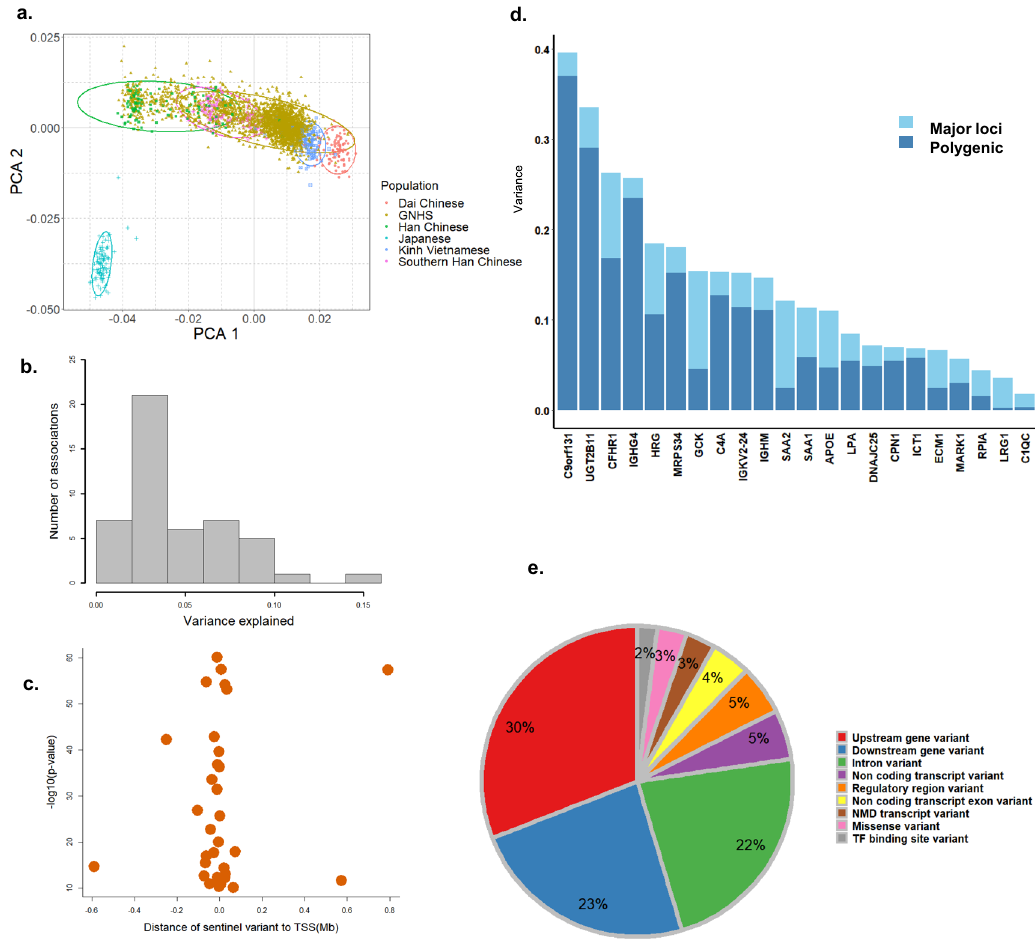
Fig. 3 | Characteristics of sentinel pQTLs. a Genetic principal component of the GNHS study compared to the 505 East Asian participants from the 1000 Genomes Project Phase3. b Distribution of explained variance that the genetic variant con- tributed to the corresponding protein. c The distance of lead variant to the tran- scriptstartsite. d Heritabilityofcirculatingproteins.Thevarianceexplainedbythe